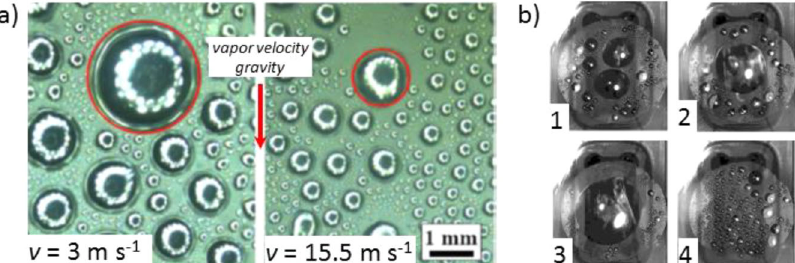
Fig. 10 Effect of vapor velocity and wettability gradient surfaces on dropwise condensation. a Effect of the vapor velocity v on droplet departing radius during DWC of steam over a vertical surface, gravity level g = 9.81 m s − 2 (Tancon et al. 79 ). b Images of DWC over a horizontal surface with wettability gradient (Mancio Reis et al. 83 ): droplets nucleate (1), grow (2), coalesce up to a certain radius (2 – 3); the biggest droplets are removed (3 – 4) towards the periphery of the treated zone and new droplets appear